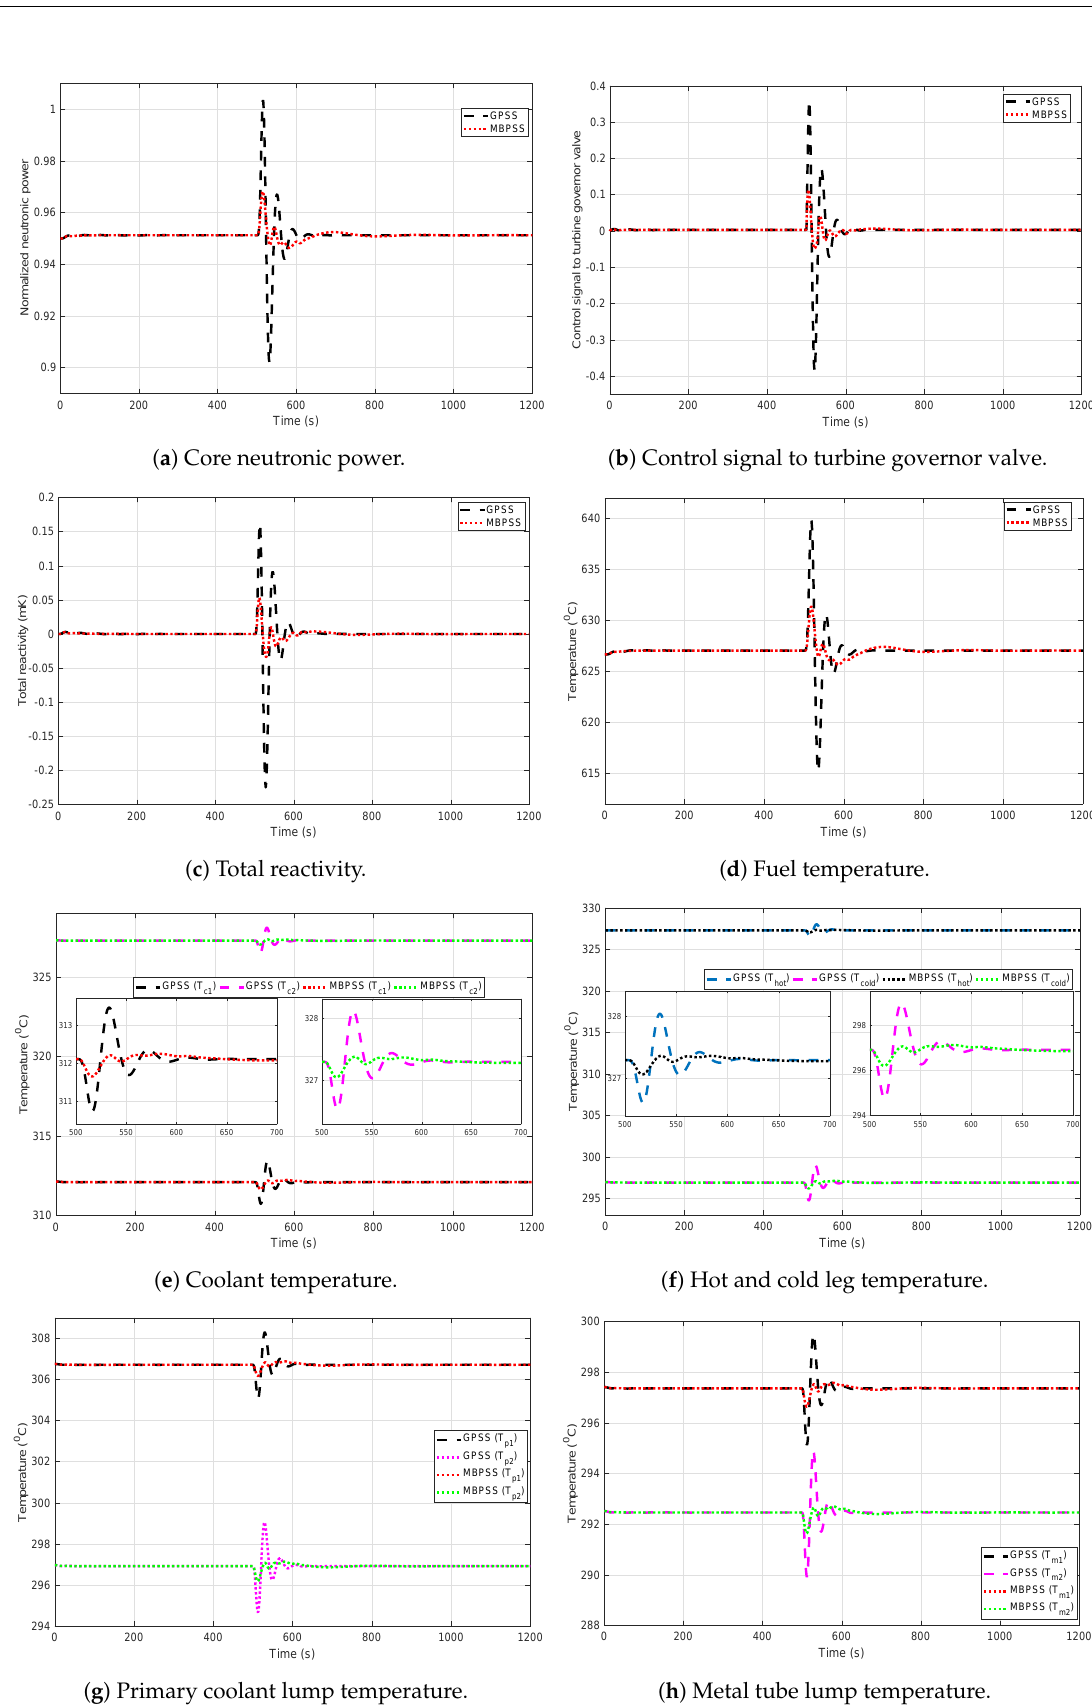
Figure 15. Case III.1: Variation in nuclear power plant variables during permanent load loss with generic and multiband PSS with